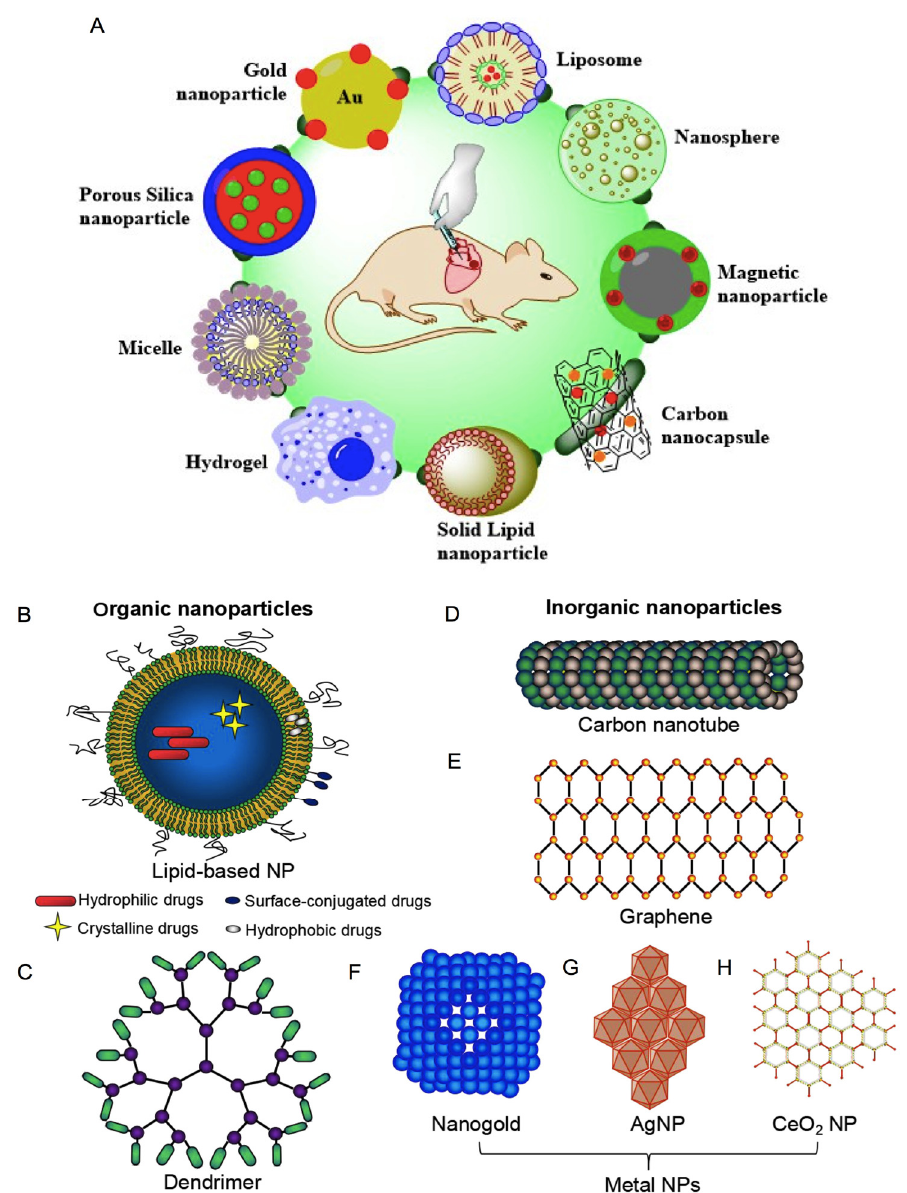
Figure 2. ( A ) Outline of the forms of drug delivery systems to treat heart disorders. Figure adapted with permission from Skourtis et al, 2020 [70]. Different NPs generally utilized in CVD therapeutic studies such as organic NPs ( B , C ), inorganic ( D – H ), and hybrid NPs. Panel reproduced with permission from Fan er al., 2020 [71].